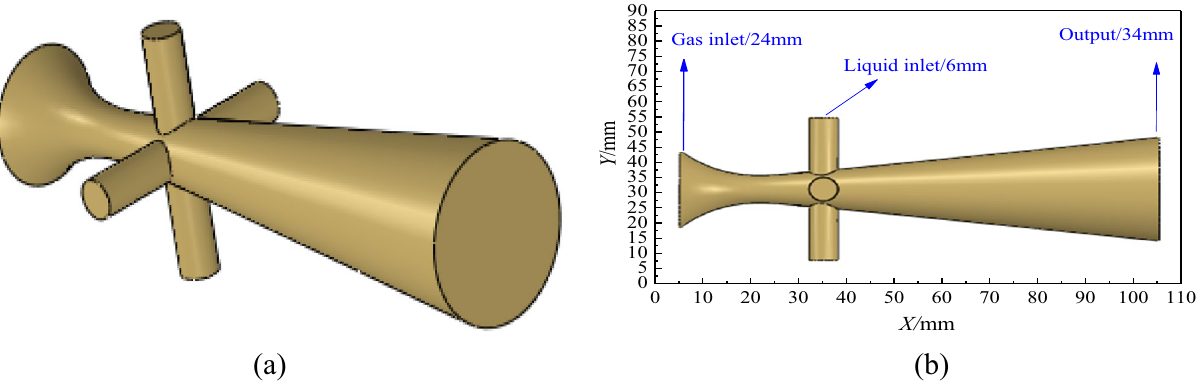
Figure 1. Supersonic atomizing nozzle model. ( a ) Three-dimensional model. ( b ) Model